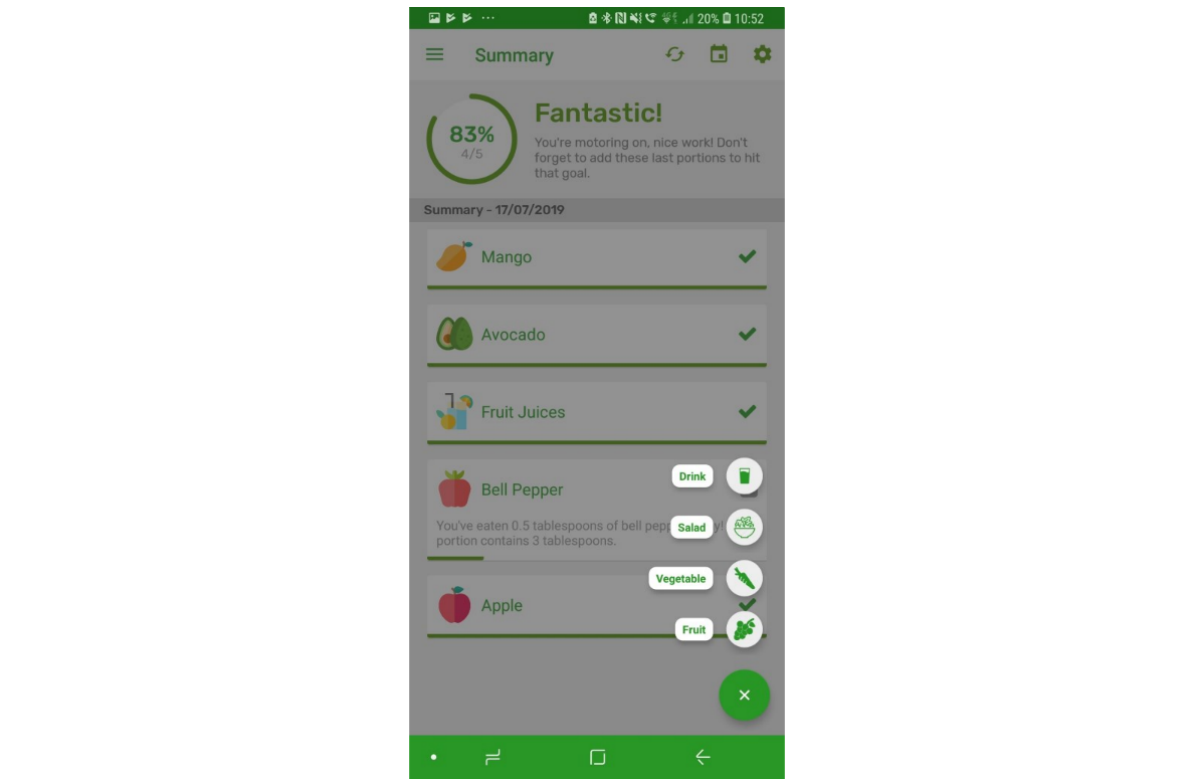
Figure 1. Screenshots of the app: fruit and vegetable